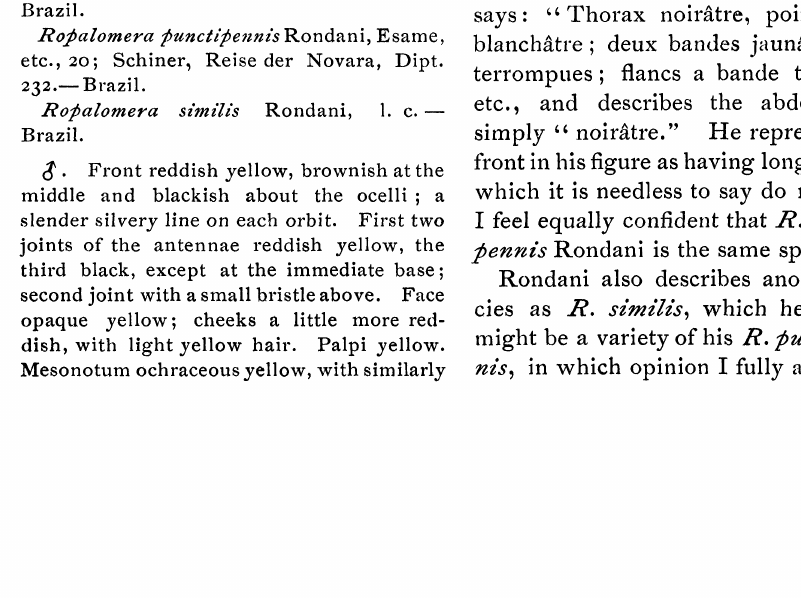
middle and blackish about the ocelli; a slender silvery line on each orbit. First two joints of the antennae reddish yellow, the third black, except at the immediate base; second joint with a small bristle above. Face opaque yellow; cheeks a little more red- dish, with light yellow hair. Palpi yellow. Mesonotum ochraceous yellow, with